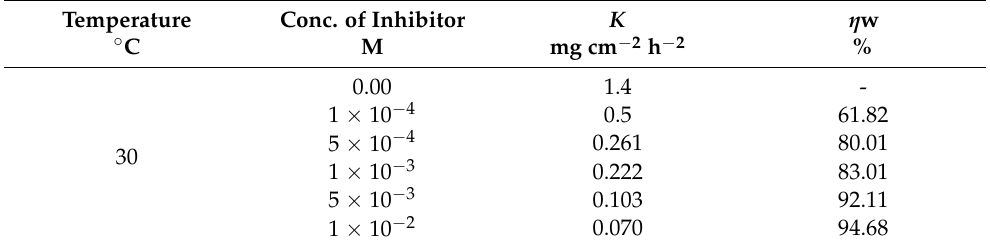
Table 4. Effect of cationic surfactant inhibitor concentration (IIc) at 30 ◦ C temperature degrees. Temperature ◦